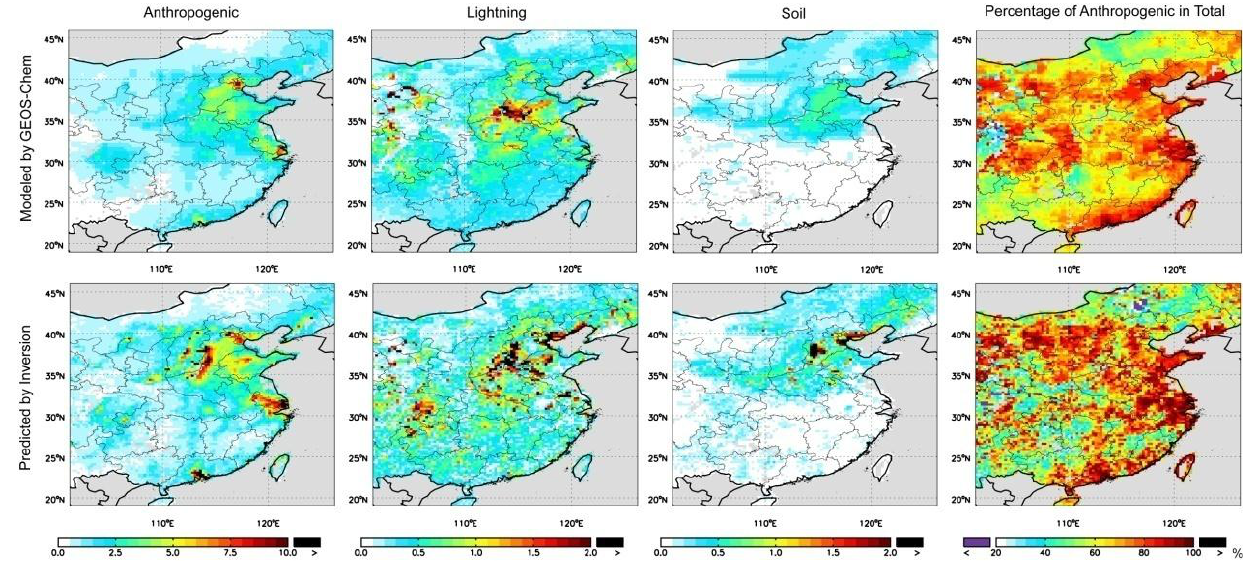
Fig. 10. VCDs of NO 2 (10 15 molec.cm − 2 ) in July 2006 over East China resulting from anthropogenic, lightning and soil emissions of NO x and the anthropogenic contributions (in percentage) to the total VCDs modeled by GEOS-Chem and predicted by the inversion. Areas outside the territory of China or without valid retrievals are shown in